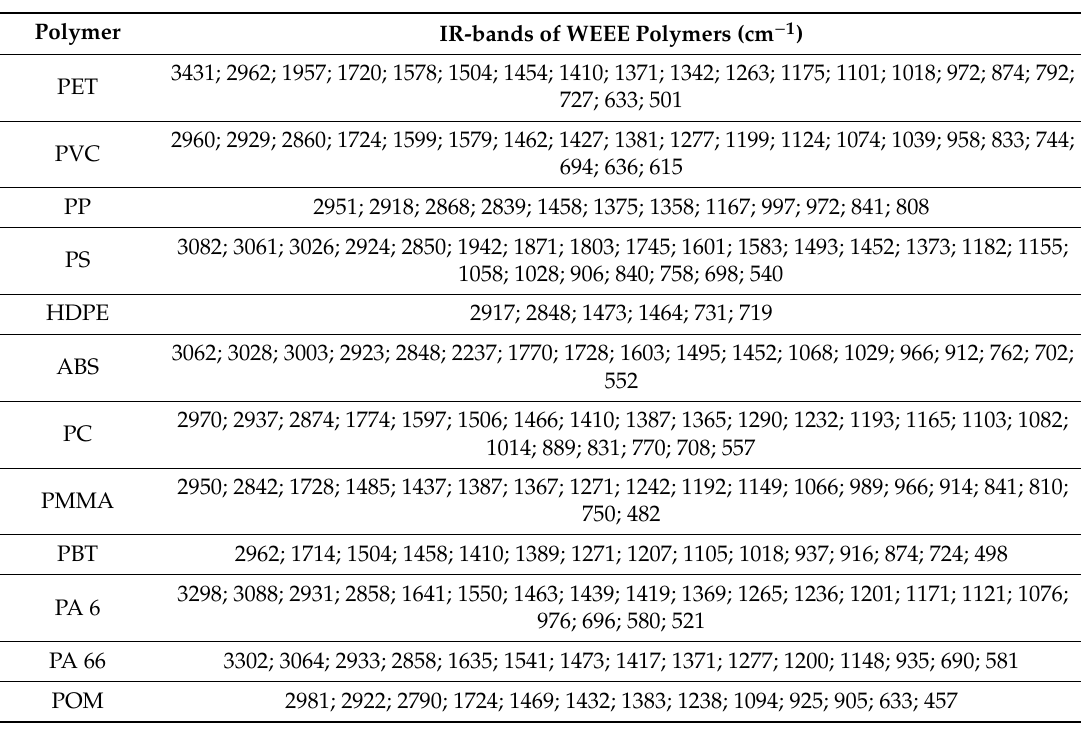
Table 5. Main absorption bands of WEEE polymers. Adapted from Braun